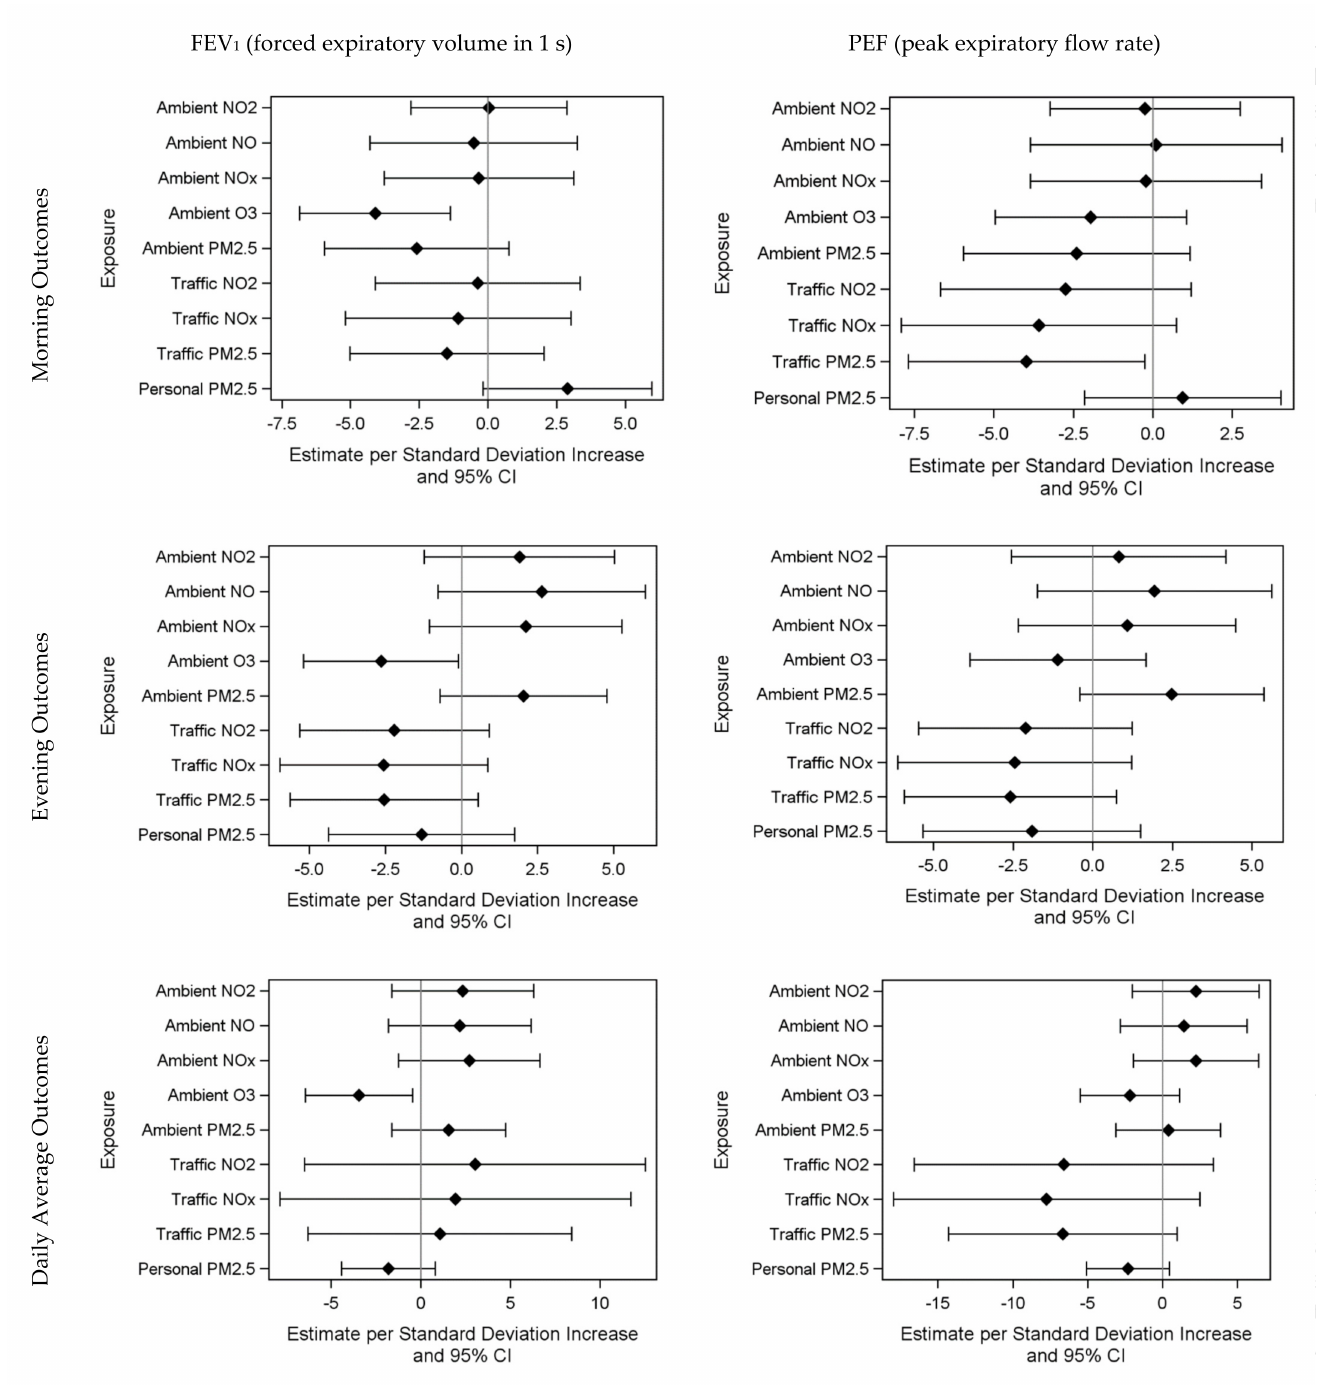
Figure 2. Association of daily air pollution exposure (lag 0) with %predicted FEV 1 and PEF. Effect estimates and 95% confidence intervals are scaled to a standard deviation change in exposure. Effect estimates were scaled to a standard deviation change in pollutant concentrations as follows: personal PM 2.5 : 9.1 µ g/m 3 ; traffic-related PM 2.5 : 0.7 µ g/m 3 ; traffic-related NO x : 14.7 ppb; traffic-related NO 2 : 7.1 ppb; ambient PM 2.5 : 3.7 µ g/m 3 ; ambient O 3 : 9.2 ppb; ambient NO x : 6.1 ppb; ambient NO: 2.4 ppb; ambient NO 2 : 4.6